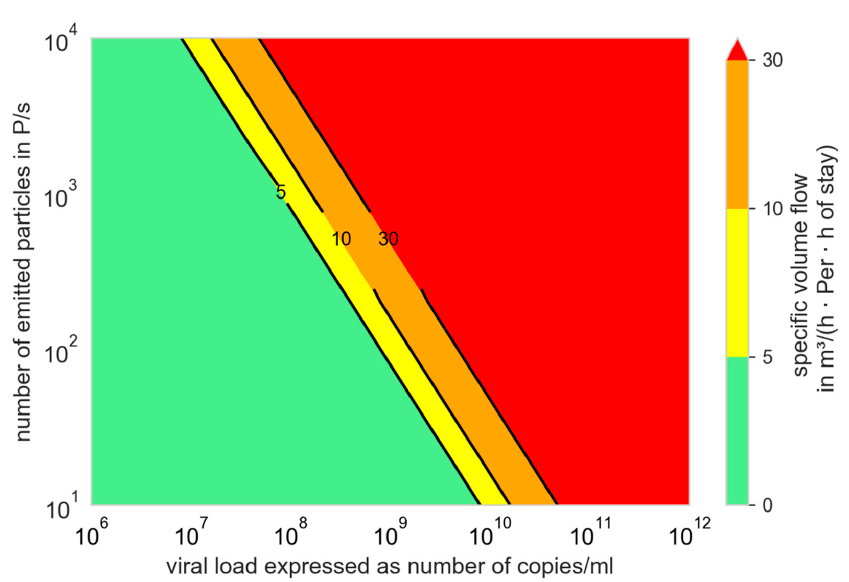
Figure 5. Specific volume flow depending on the number of emitted particles and the viral load to limit the number of newly infected persons to one; N 0 = 100 viral copies, f M = 1, Q b,in = Q b,ex = 0.54 m 3 /h.